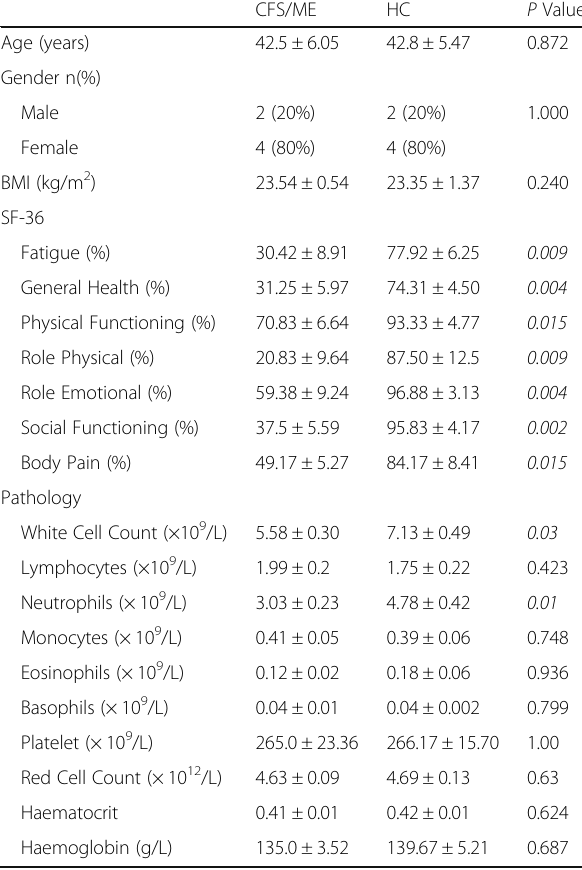
Table 1 Blood parameters and patient demographic